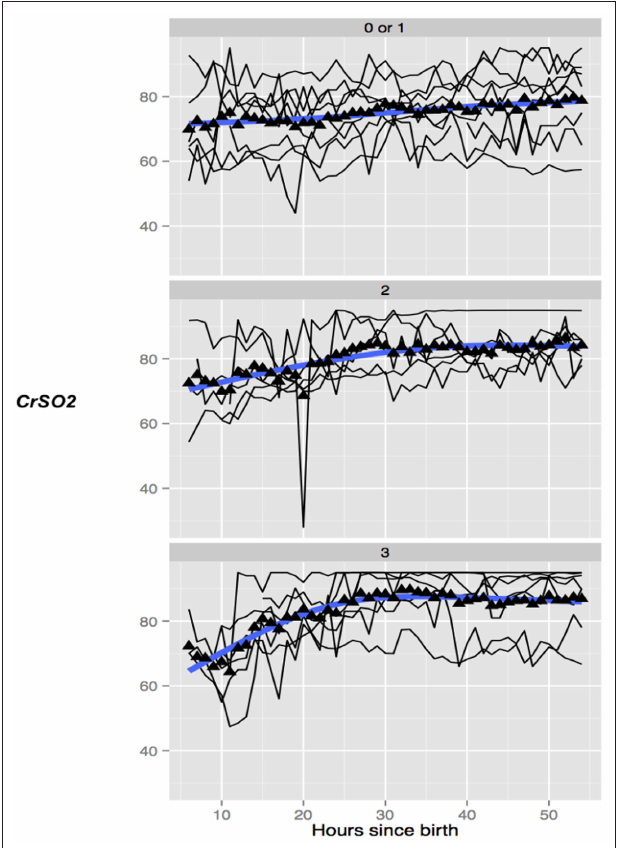
FIGURE 3 | Trend of absolute cerebral tissue oxygen saturation (CrSO 2 ) values in 3 groups of infants undergoing TH with none/mild (top), moderate (middle), and severe (bottom) grade of overall MRI injury. The mean values in the group are marked with a solid triangle while the individual infants are represented by thin black lines. CrSO 2 in infants with no or mild MRI injury (top) remains relatively stable while in infants with moderate (middle) and severe (bottom) CrSO 2 shows a trend toward an early increase. Reproduced with permission, Jain et al. (